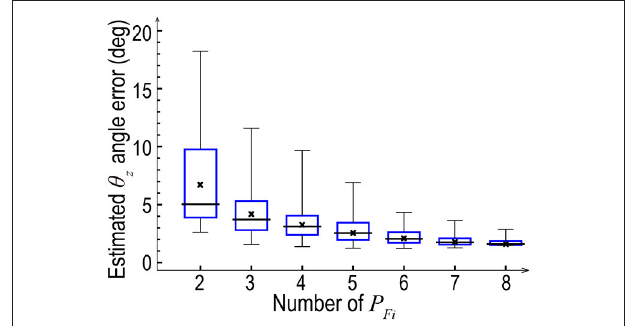
FIGURE 16 | Estimated θ z using different numbers of P F